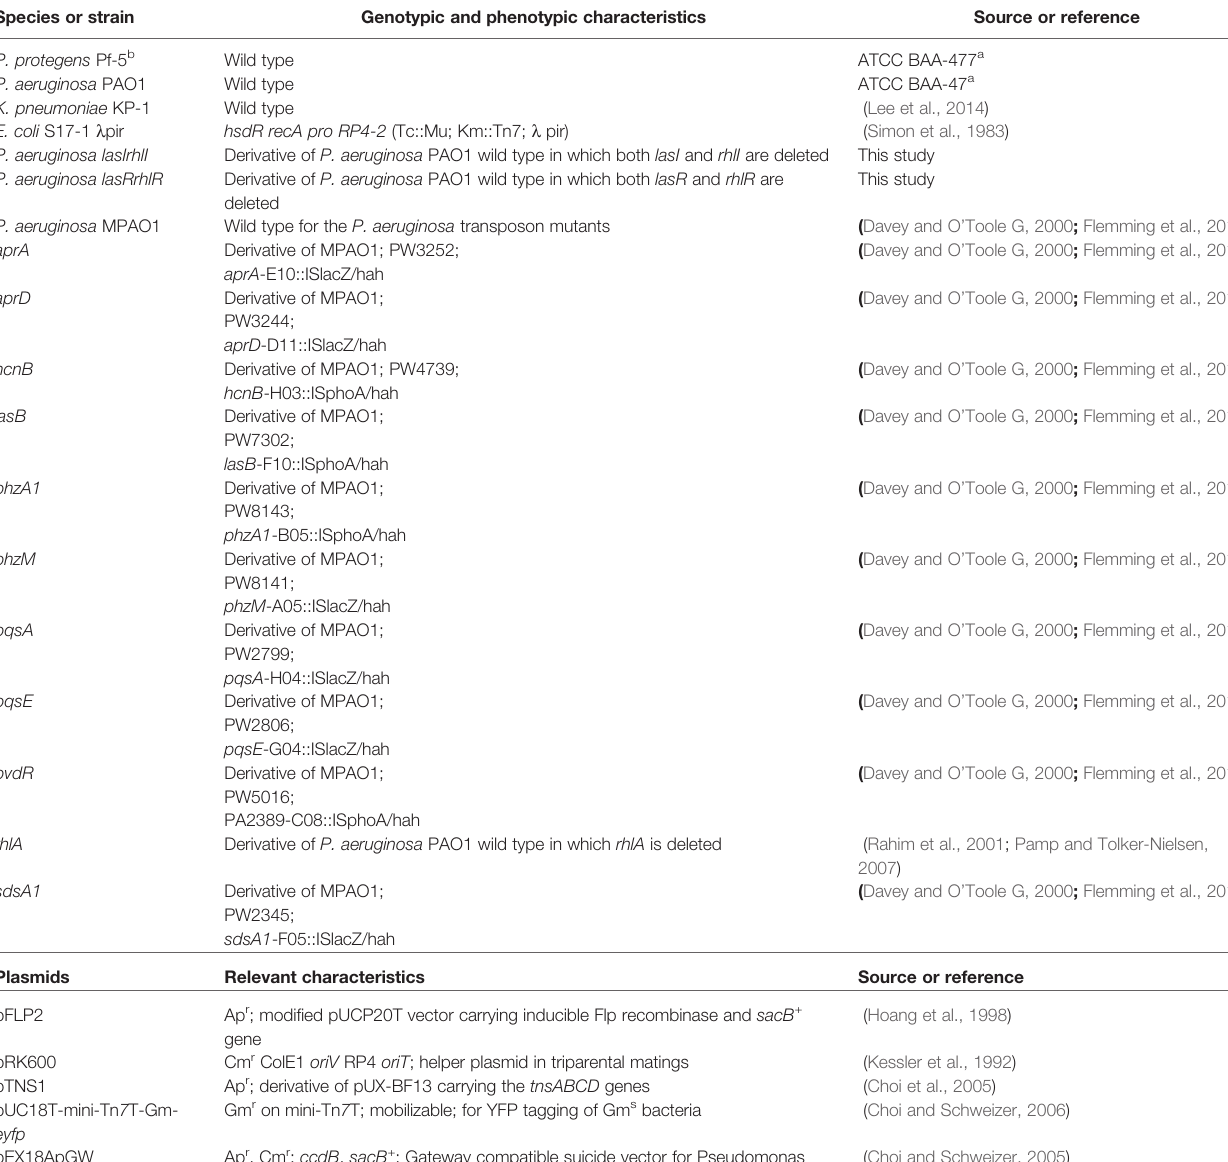
TABLE 1 | Bacteria and plasmids used in this